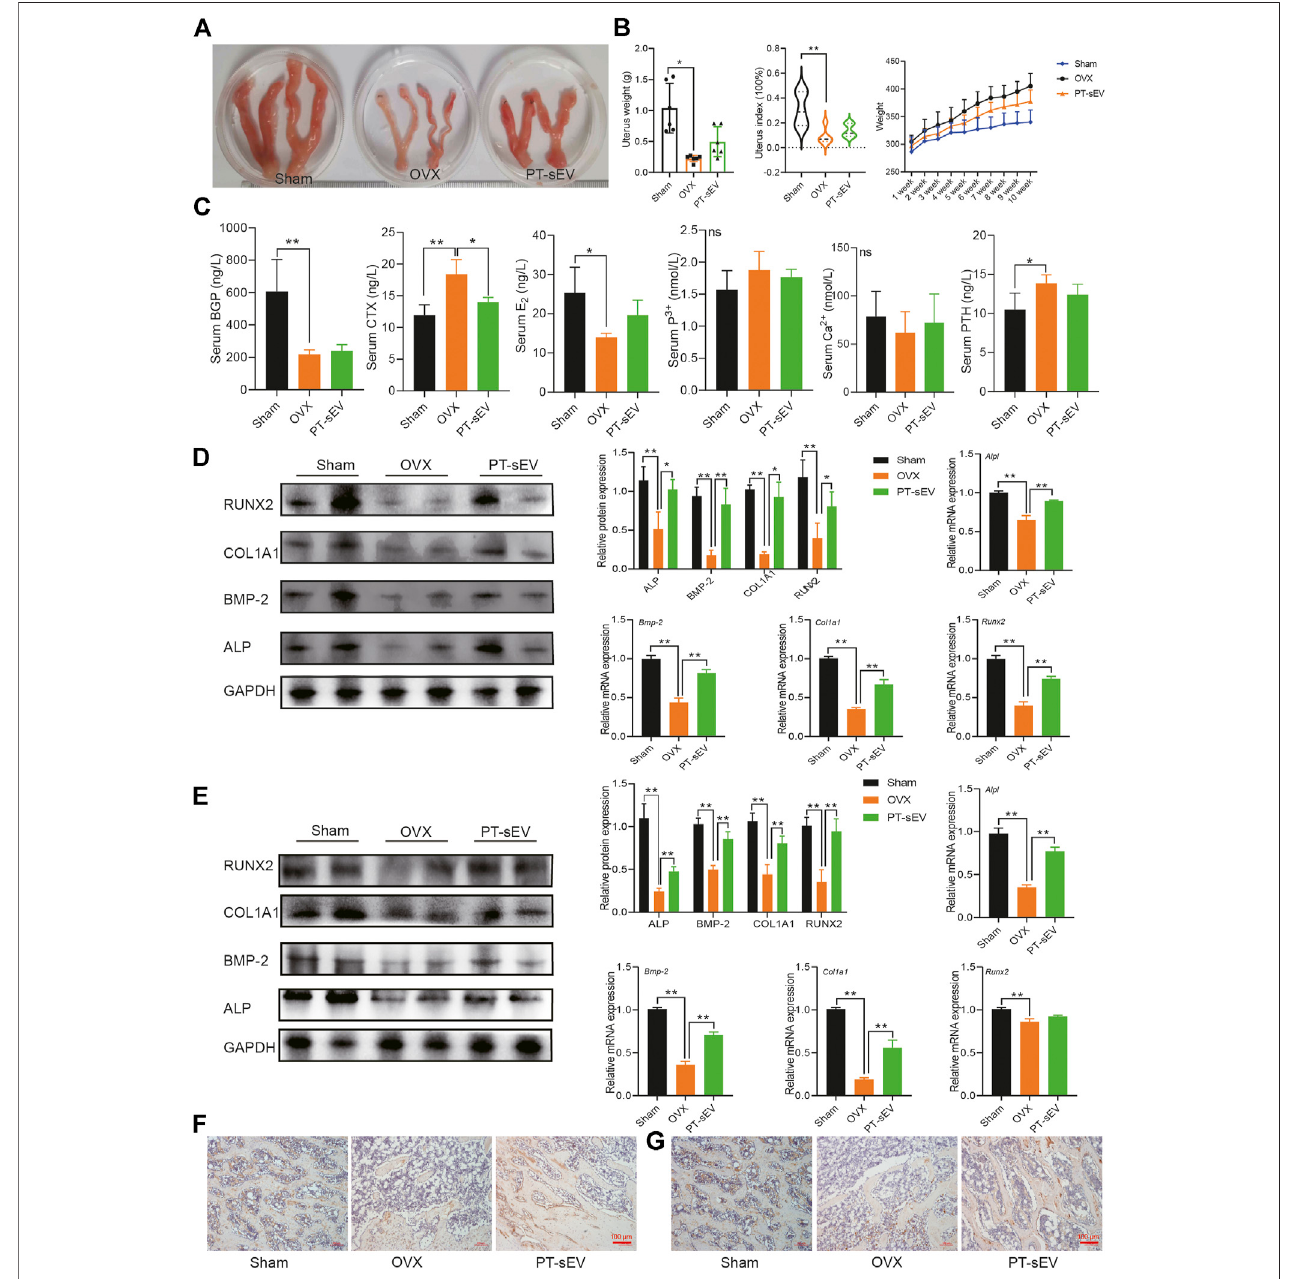
FIGURE 4 | PT-sEV stimulated the expression of bone turnover markers and osteogenesis related factors in OVX rats. (A) The morphology of uterus in different group ( n (cid:2) 2); (B) The uterus weight, uterus index and body weight in different groups ( n (cid:2) 6), the raw data represented the replicate value; (C) The content of bone turnover biomarkers in serum, the raw data represented the replicate value; (D) The protein and mRNA expression of osteogenic related factor in femur, the normalized data represented the mean ± SD; (E) The protein and mRNA expression of osteogenic related factor in lumbar vertebrae, the normalized data represented the mean ± SD; (F) ICH results of COL1A1 in femur; (G) ICH results of COL1A1 inlumbar vertebrae, scale bar: 100 μ m * p < 0.05, ** p < 0.01, analyses were done twice and obtained comparable results.